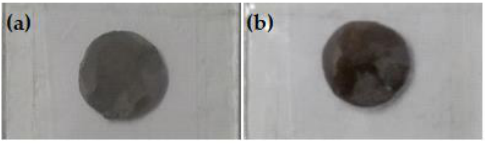
Figure A2. Lithium disk samples immersed for 2 days in ( a ) LP30 and ( b ) PC, both with the addition of 250 mM NH 4 PF 6 .